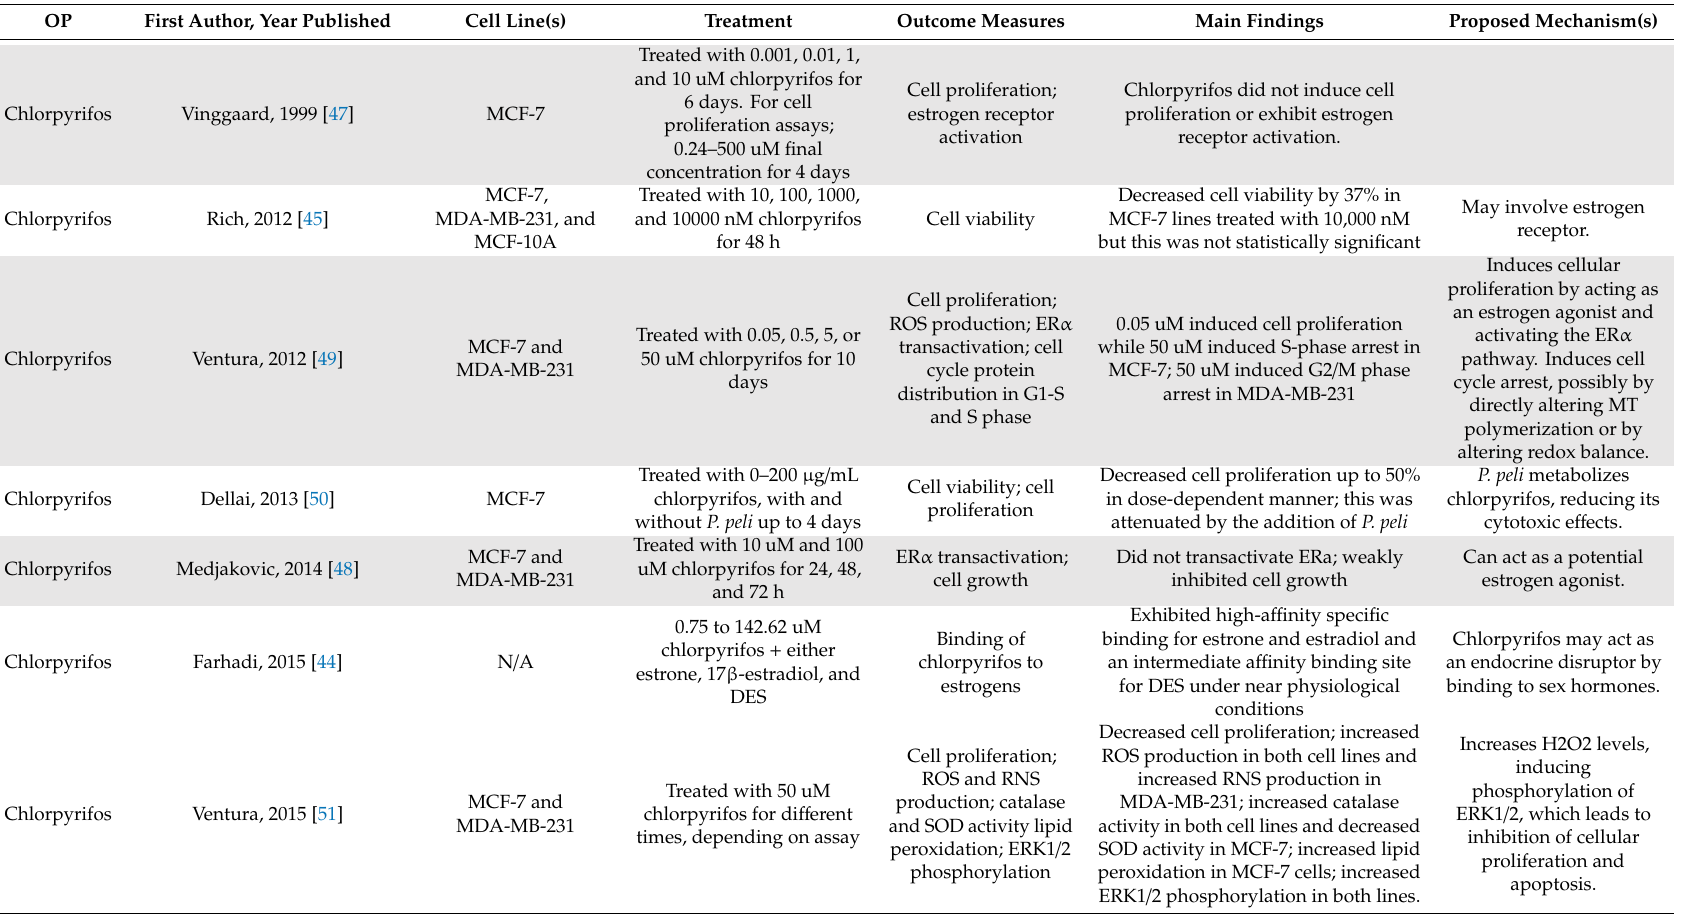
Table 3. Summary of in vitro studies on organophosphate pesticides and mammary cell